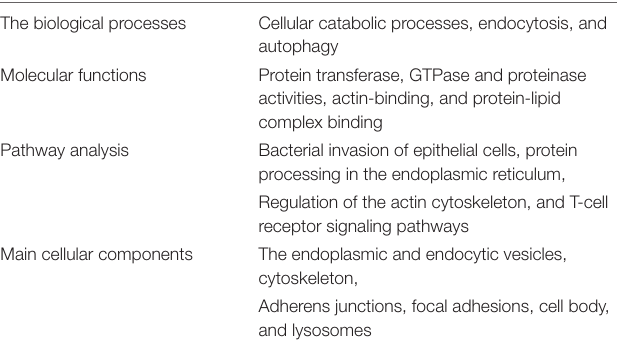
The biological processes Cellular catabolic processes, endocytosis, and autophagy Molecular